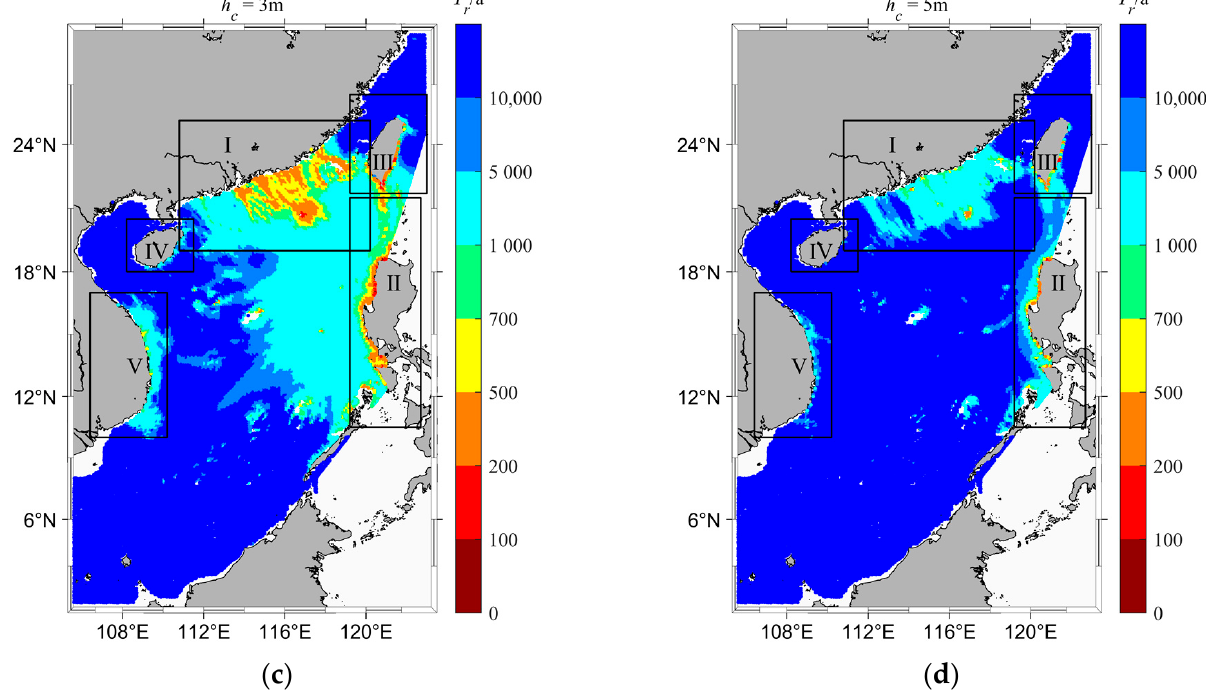
Figure 4. The spatial distribution of return period ( T r ) when critical wave height h c = 1 m, 2 m, 3 m and 5 m. ( a ) h c = 1 m, ( b ) h c = 2 m, ( c ) h c = 3 m, ( d ) h c = 5 m.